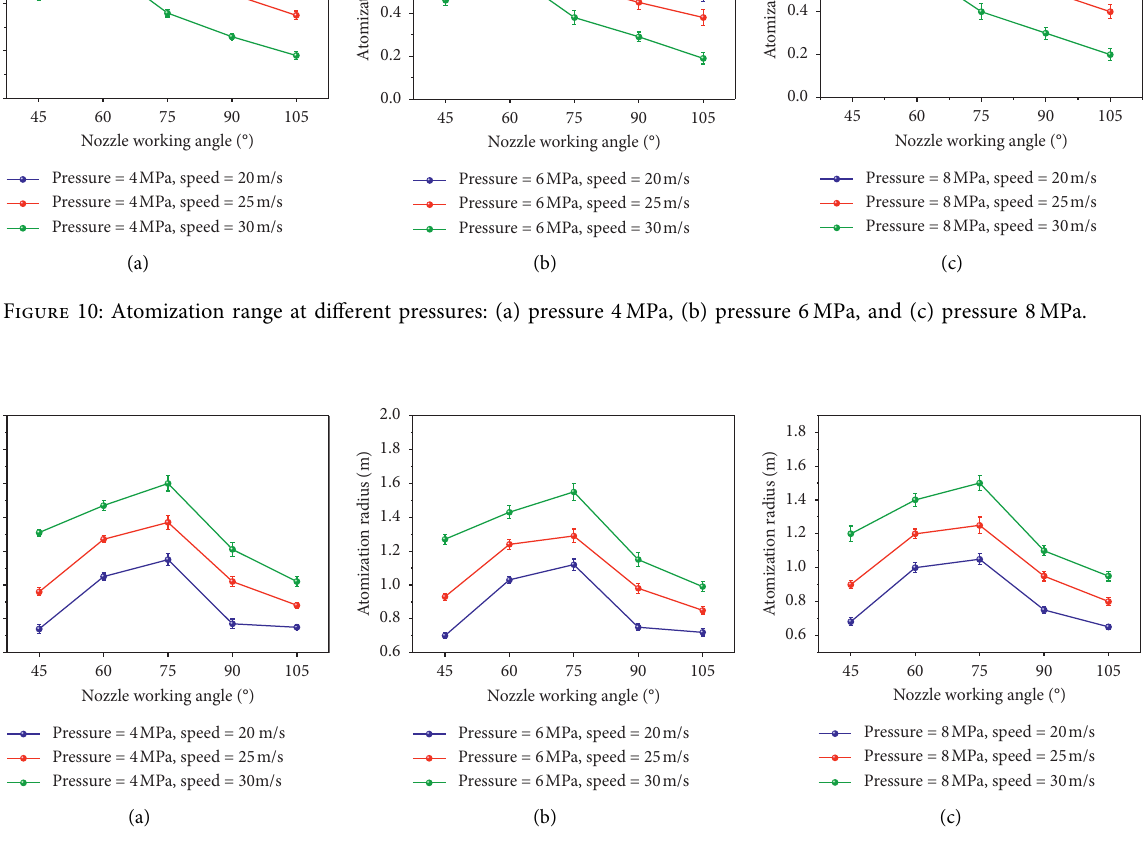
Figure 11: Atomization radius at different pressures: (a) pressure 4 MPa, (b) pressure 6MPa, and (c) pressure 8MPa.